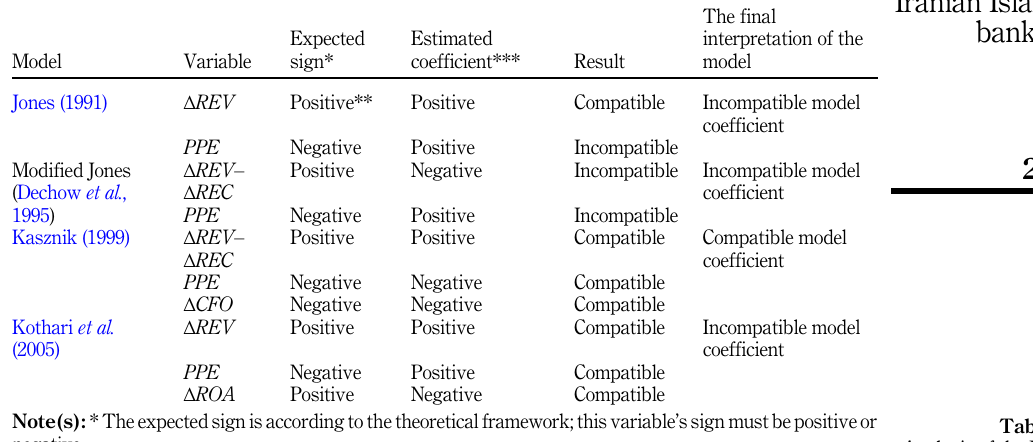
Table 7. Analysis of the